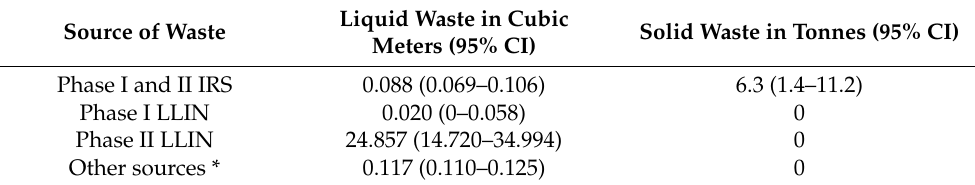
Table 1. Insecticidal waste generated per year from 2018 to 2021 at